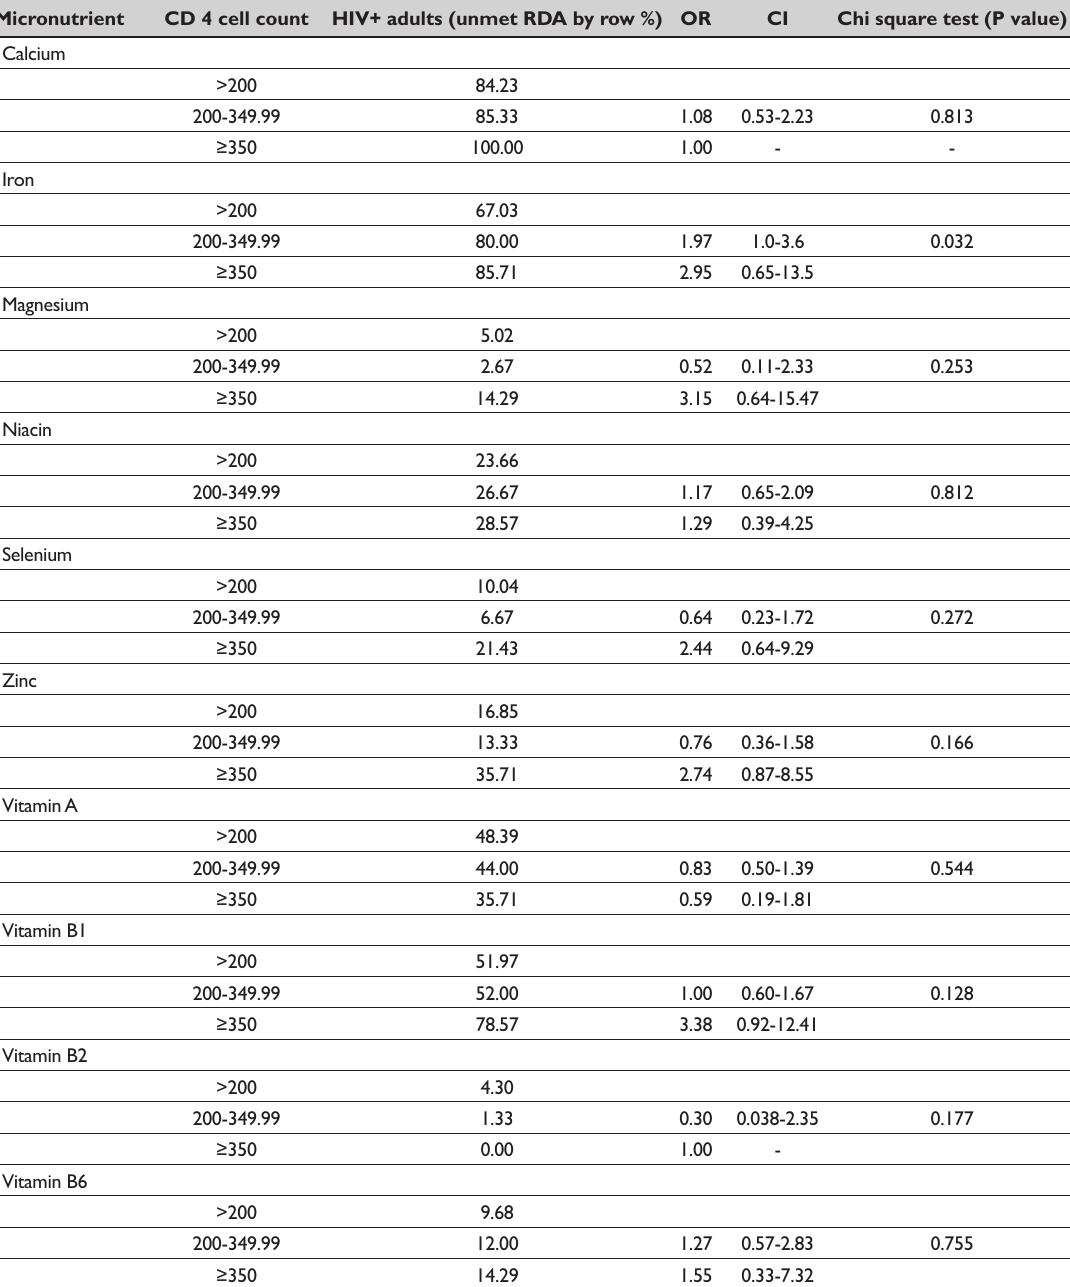
Table 4: Bivariate analysis for micronutrient intake by CD4 cell count among HIV+ patients initiating HAART